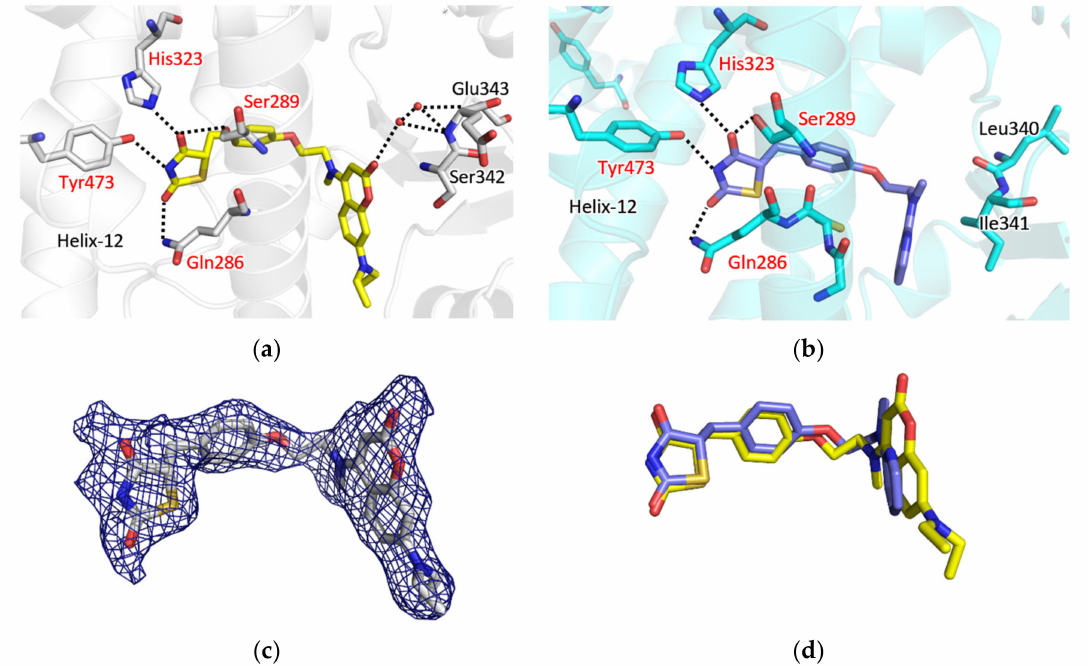
Figure 6. ( a ) Hydrogen bonds between 2 and hPPAR γ -LBD (PDB code: 7EFQ). ( b ) Hydrogen bonds between rosiglitazone and hPPAR γ -LBD (PDB code: 2PRG). ( c ) Omit map of 2 bound to hPPAR γ -LBD. ( d ) Comparison of 2 with rosiglitazone bound to hPPAR γ